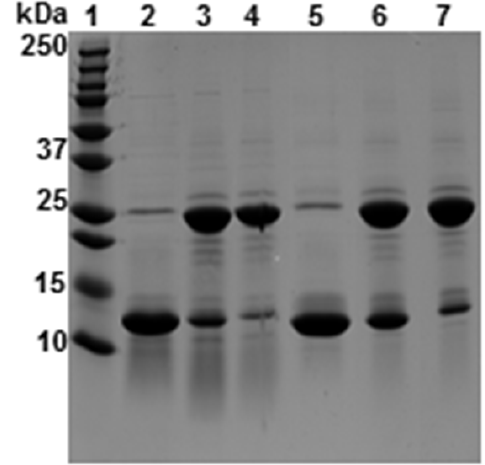
Figure 2. SDS-polyacrylamide gel electrophoresis of the wild-type peptides under reducing and non-reducing conditions. Tpm1.1 64–154 (lanes 2–4) and Tpm3.12 65–155 (lanes 5–7) separated on the SDS- gels after incubation for 3 min at 100 °C with Laemmli solution in the presence of 10% β -mercap- toethanol (lanes 2 and 5), in the absence of β -mercaptoethanol (lanes 3 and 6), or neither with boiling nor β -mercaptoethanol (lanes 4 and 7).